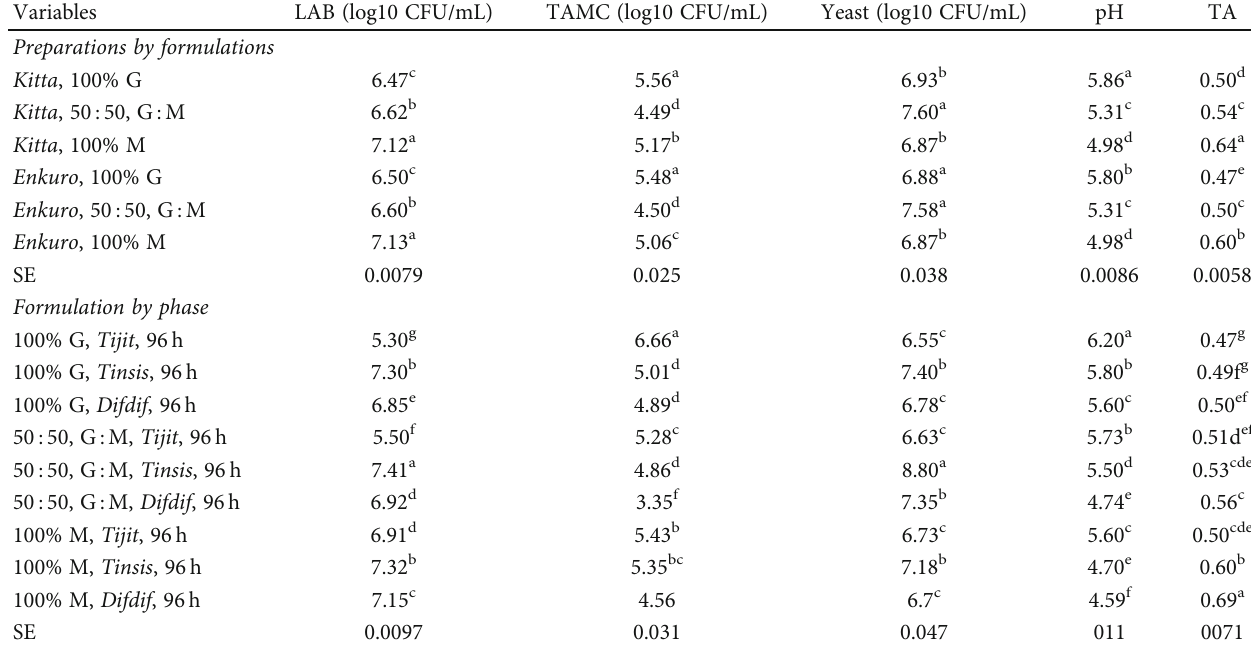
Table 1: Biochemical properties of tella samples as in fl uenced by combined e ff ects of formulation and fermentation phases. Variables LAB (log10 CFU/mL) TAMC (log10 CFU/mL) Yeast (log10 CFU/mL) pH TA Preparations by formulations Kitta , 100% G Kitta , 50 :50, G :M Enkuro , 100% G Enkuro , 50 :50, G :M Enkuro , 100% M